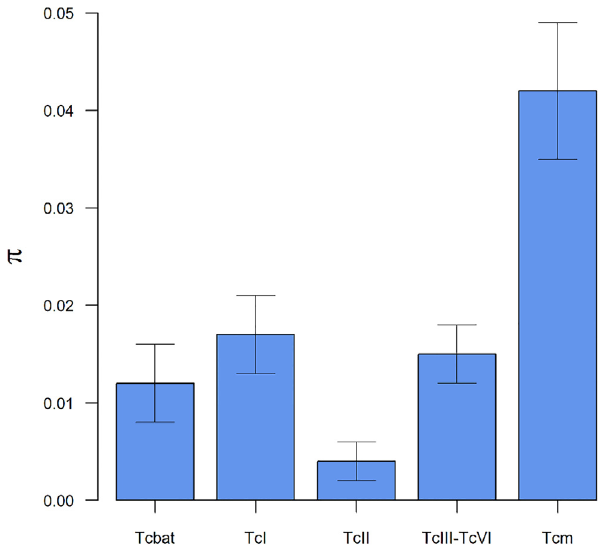
Fig 3. Mitochondrial diversity of Trypanosoma cruzi . Nucleotide diversity ( π ) of mitochondrial lineages of Trypanosoma cruzi calculated for the haplotypes of the cytb gene. The subspecies T . c . marinkellei shows larger nucleotide diversity than the other examined lineages. Whiskers in each bar indicate the standard